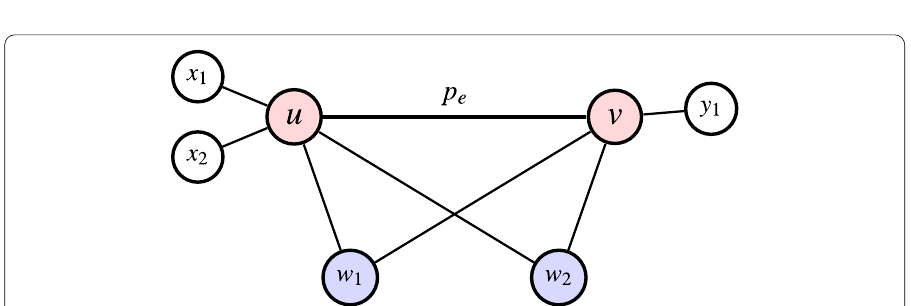
Fig. 4 The effect of changing p e on discrepancy of other